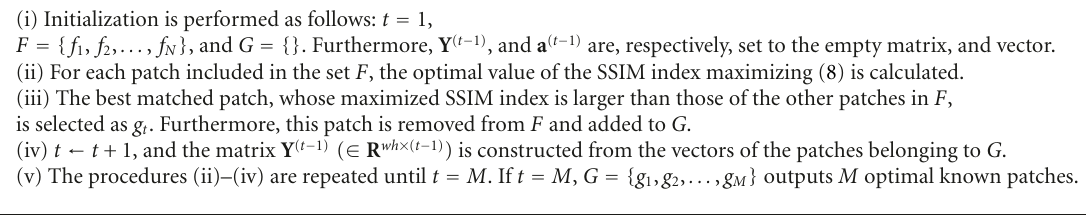
Algorithm 1: Specific procedures to select M optimal known patches g j ( j = 1,2, ... , M ) for the target patch f based on the SSIM